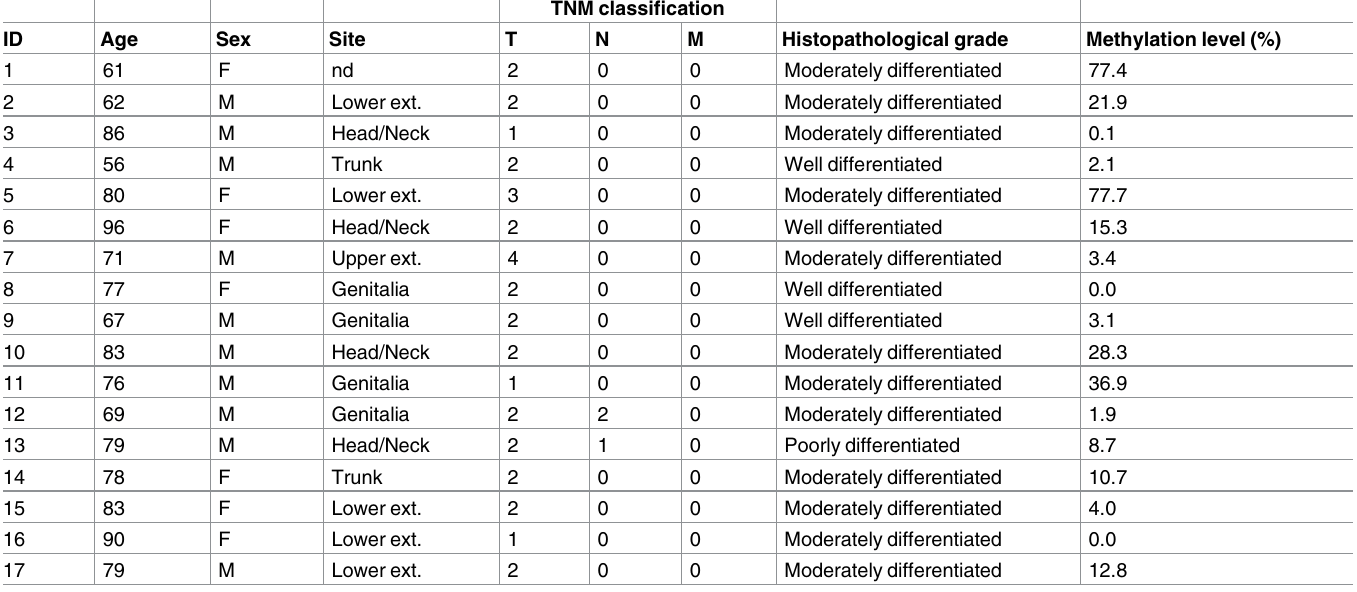
Table 1. Characteristics of the SCC sample donors and methylation levels of the samples.